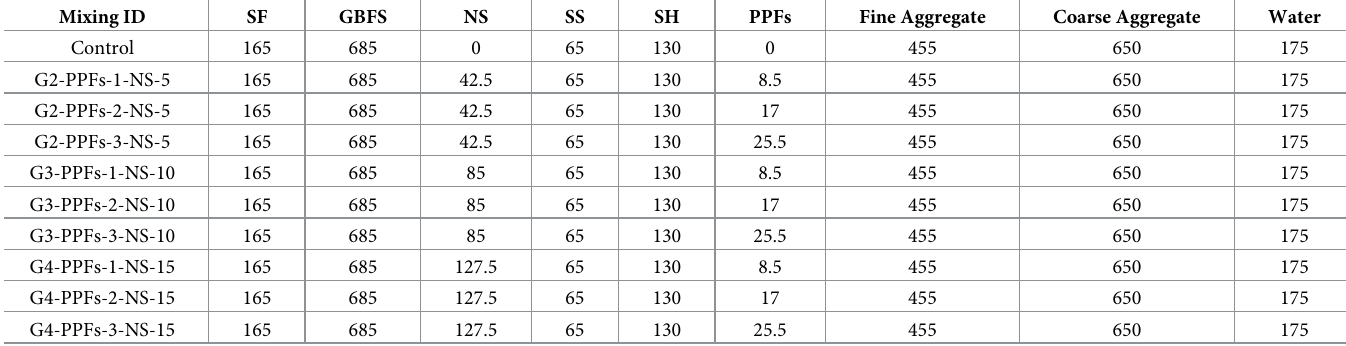
Table 4. Mix design of materials (kg/m 3